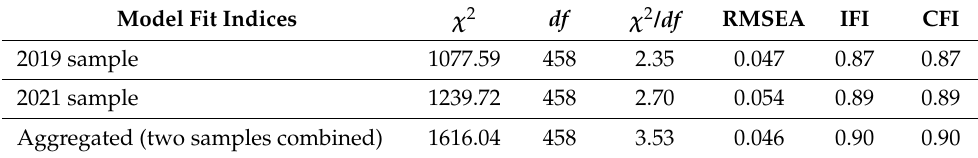
Table 8. Assessment indices.